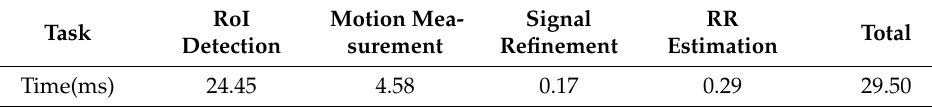
Table 10. Inference time of each respiration estimation on